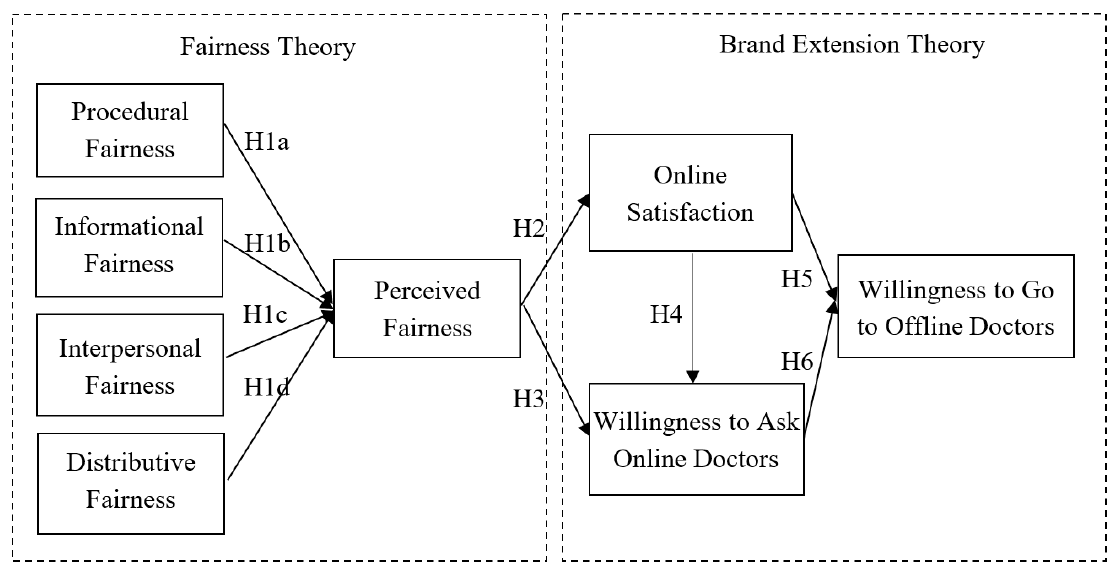
Figure 2. Research model for sustainable